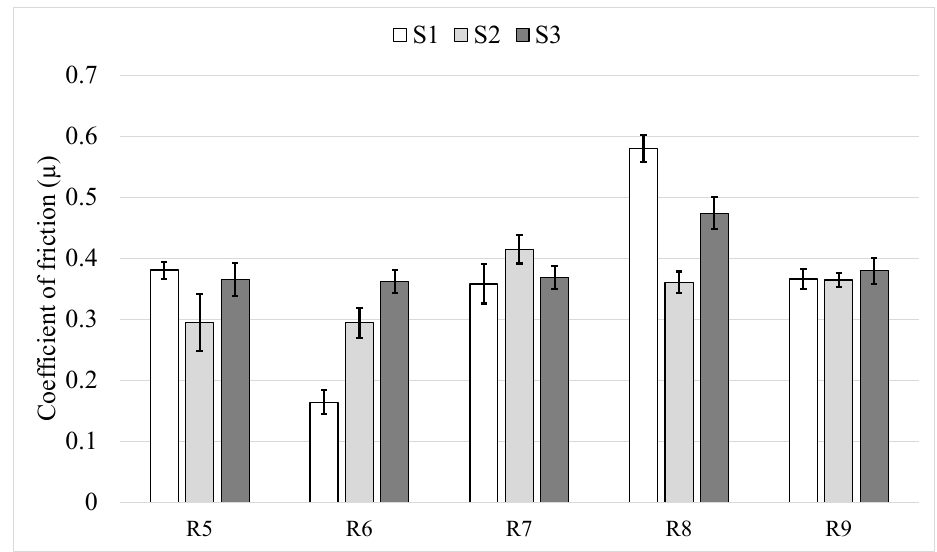
Figure 5. Average CoF value for all the fifteen tests.